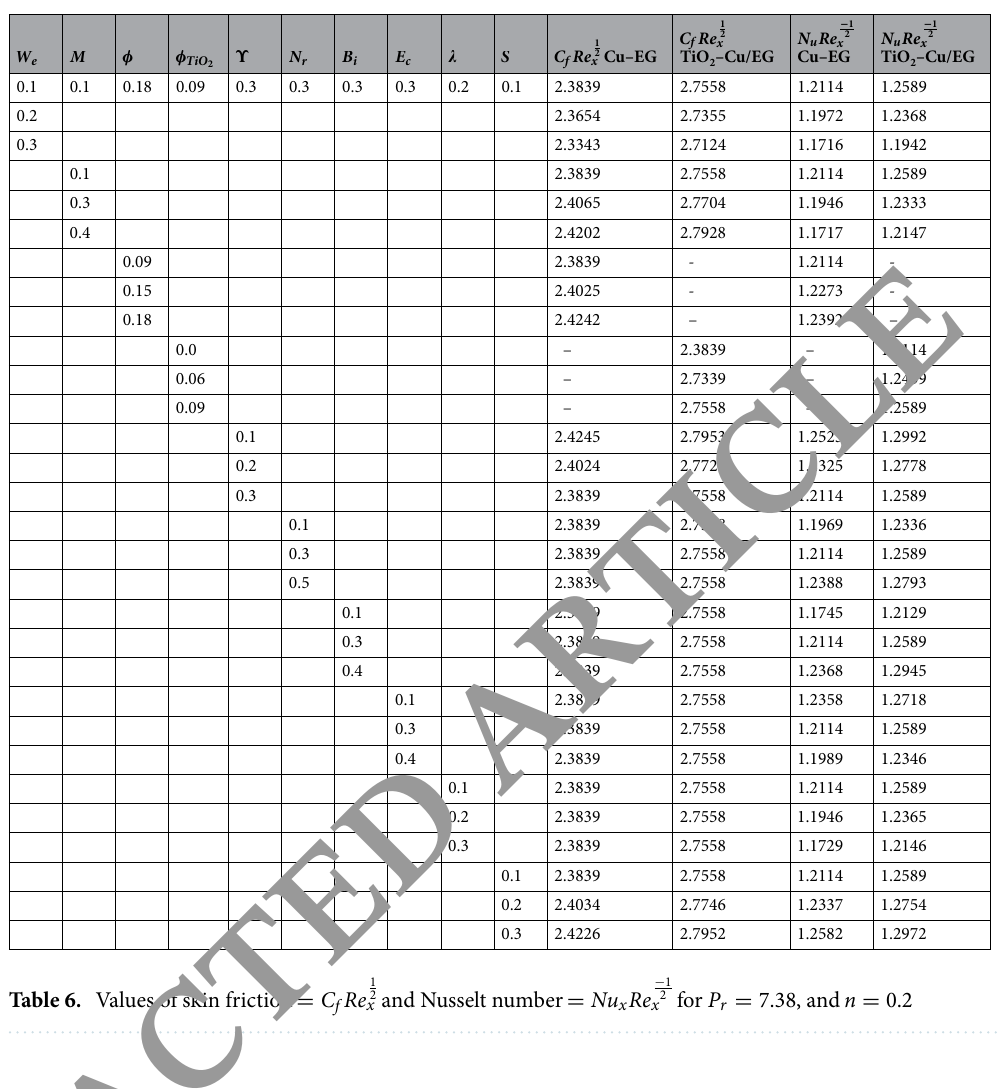
Table 6. Values of skin friction